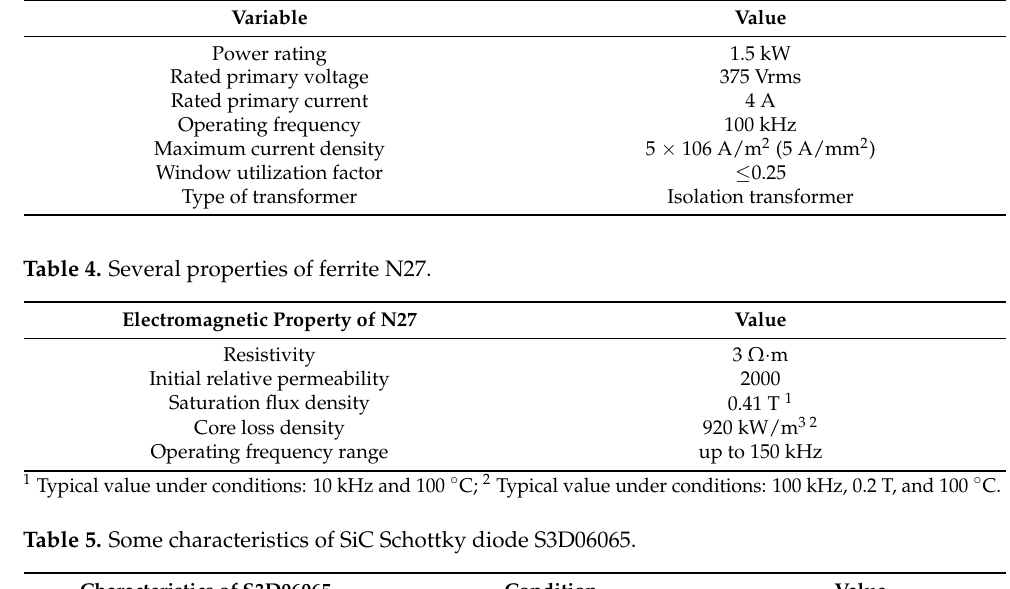
Table 3. Design specifications for the prototype HF transformer.